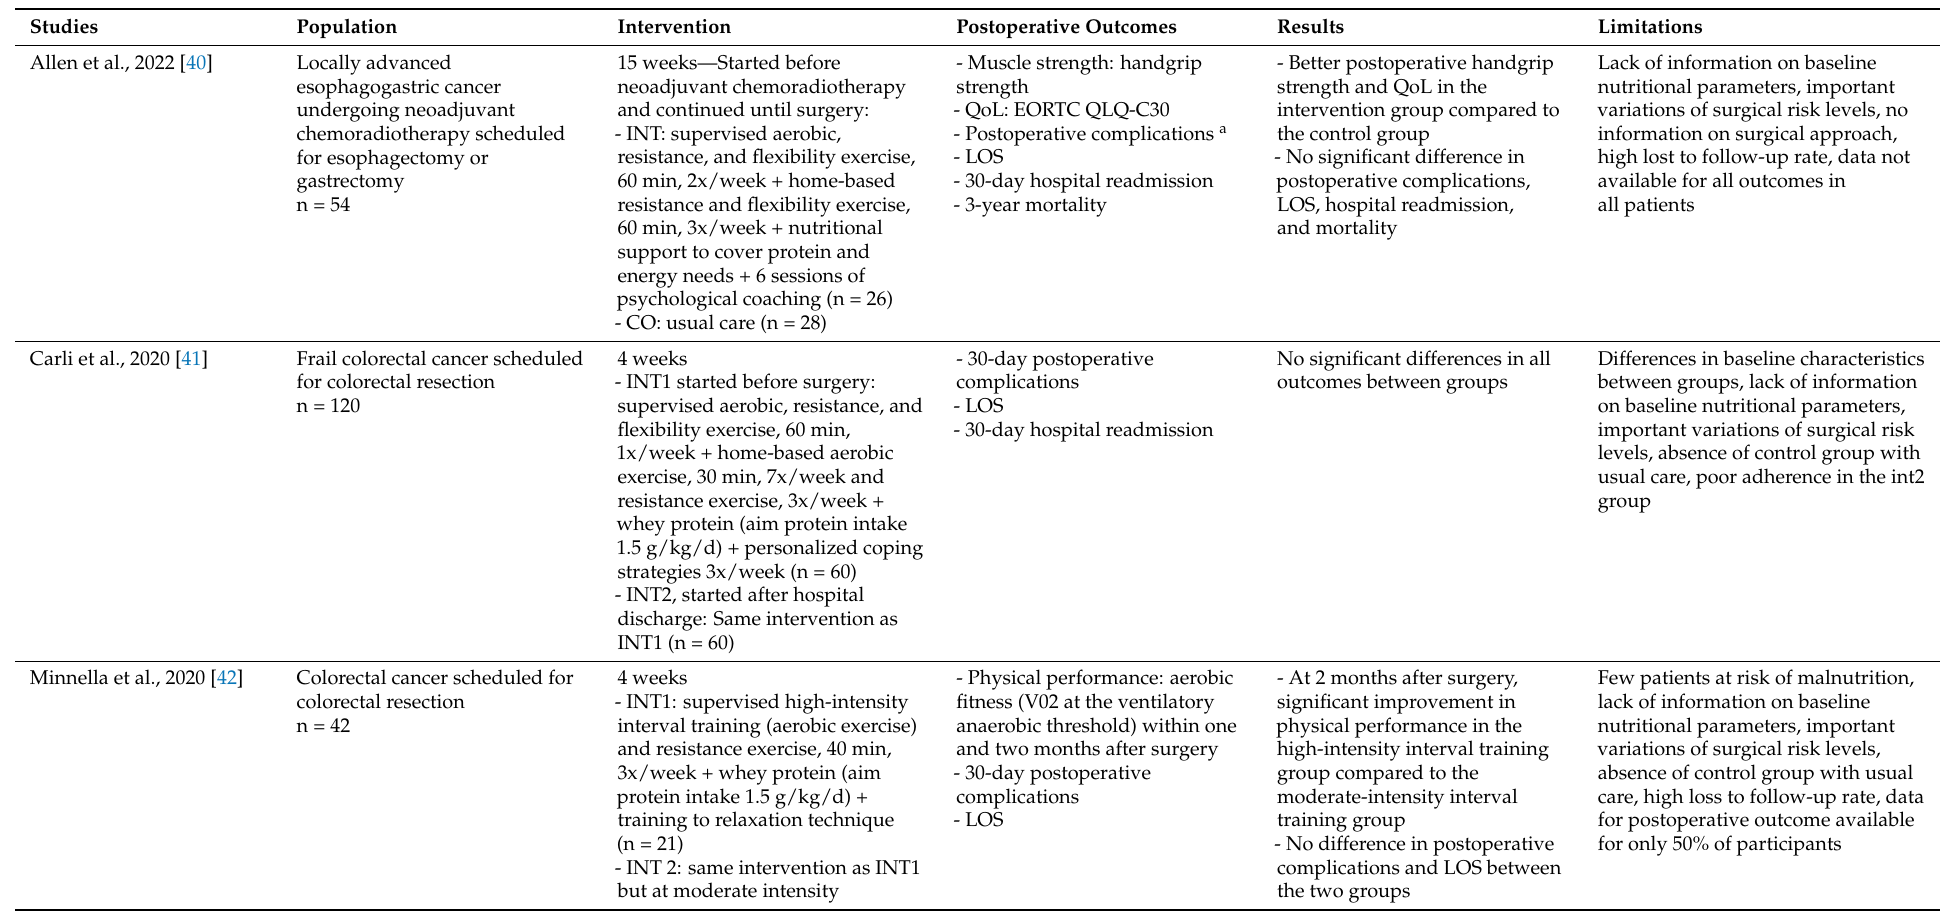
Table 5. Multimodal interventions before surgery in patients with gastrointestinal